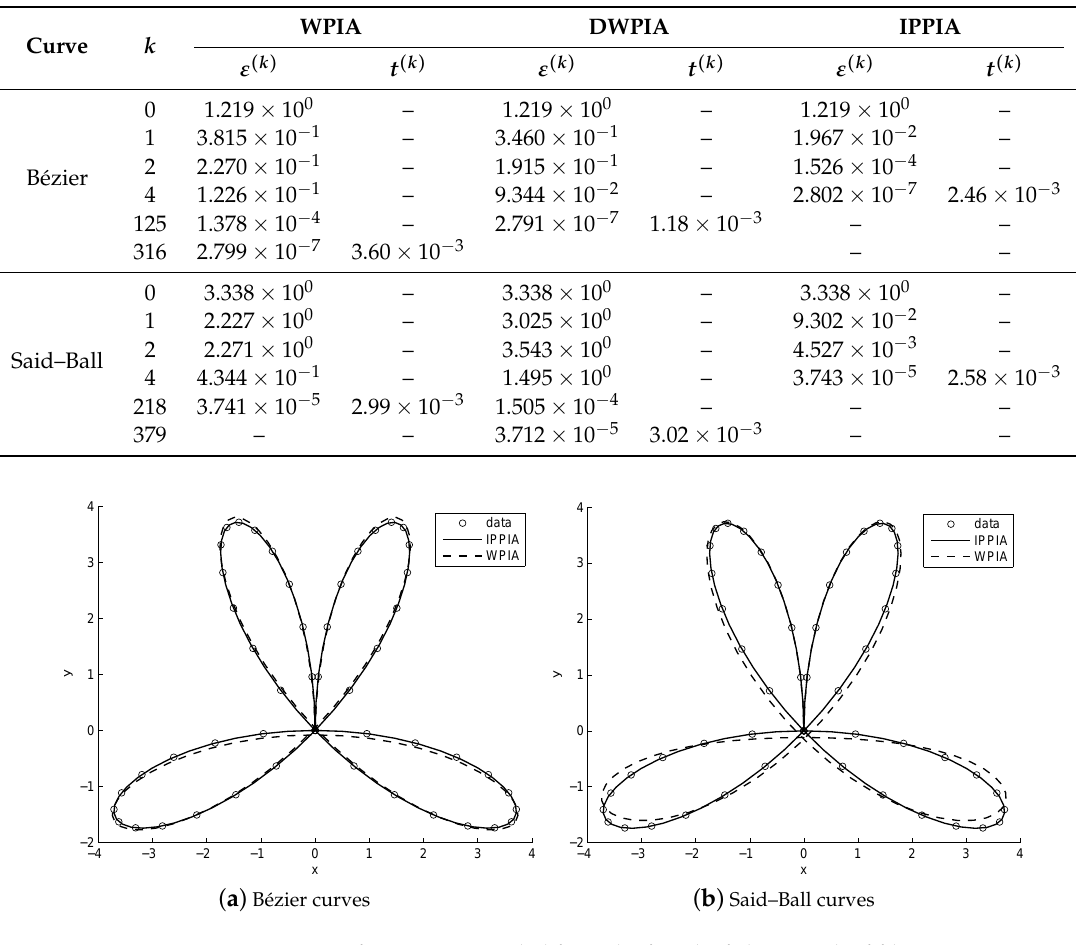
Figure 9. Approximations of 53 points sampled from the four-leaf clover at the fifth